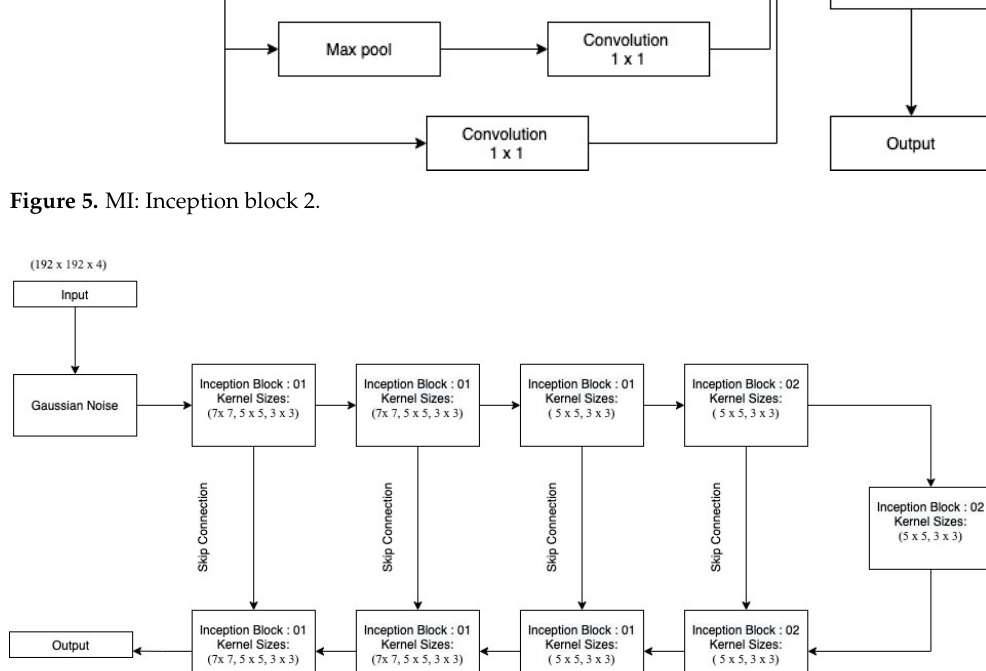
Figure 6. First proposed Architecture: Multi-Inception